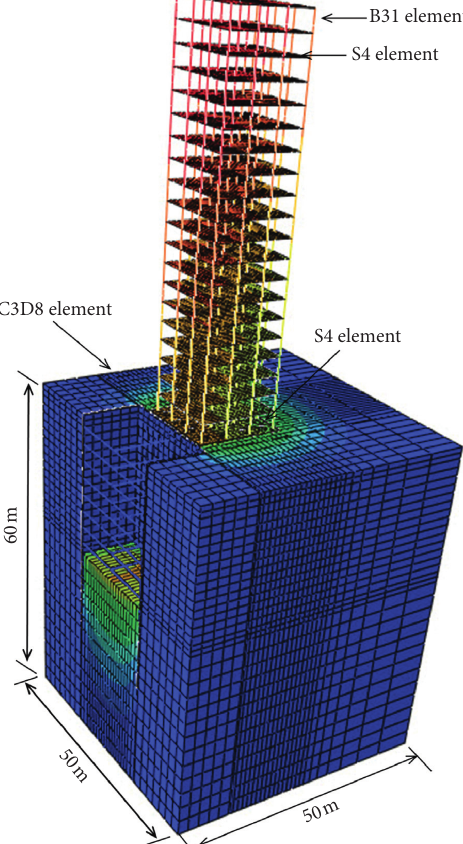
Figure 3: 3D finite element mesh (showing the model of building, raft, and ground).